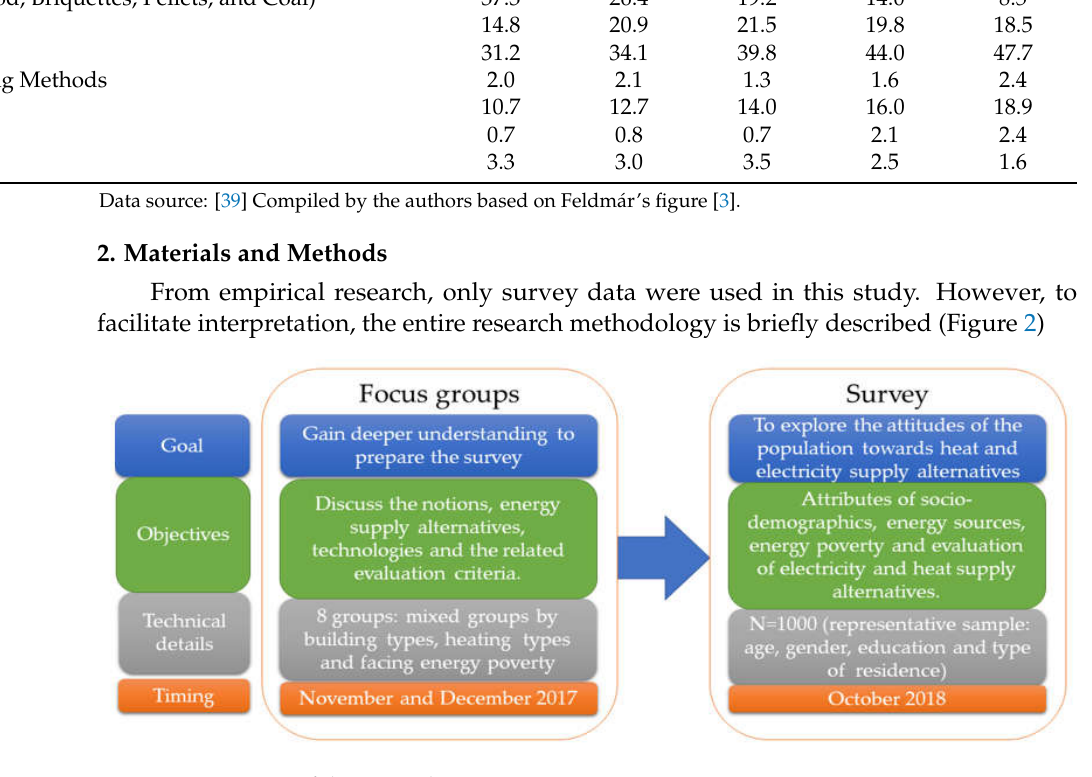
Figure 2. Overview of the research